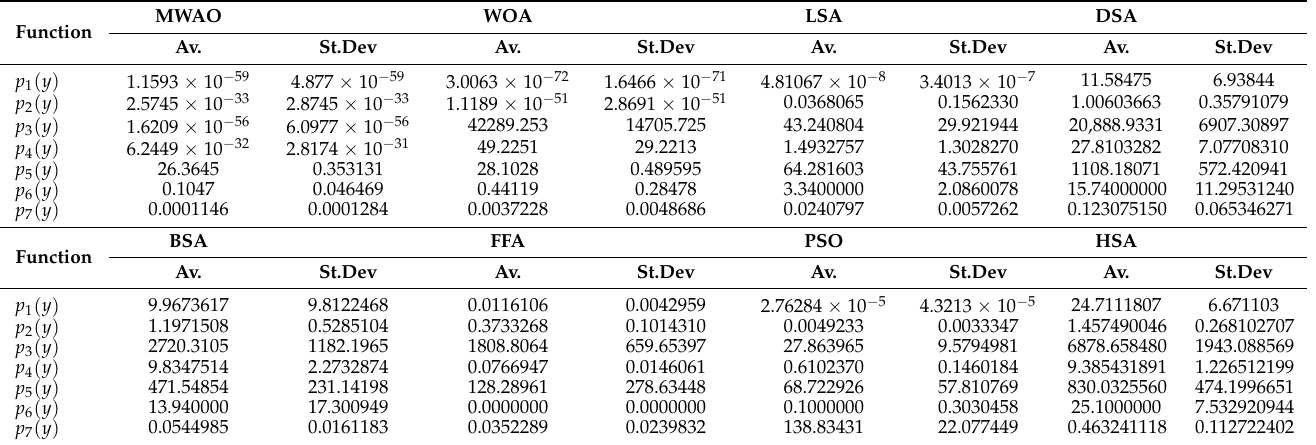
Table 2. Statistical outcomes of algorithms obtained from 30-dimensional unimodal functions after 50